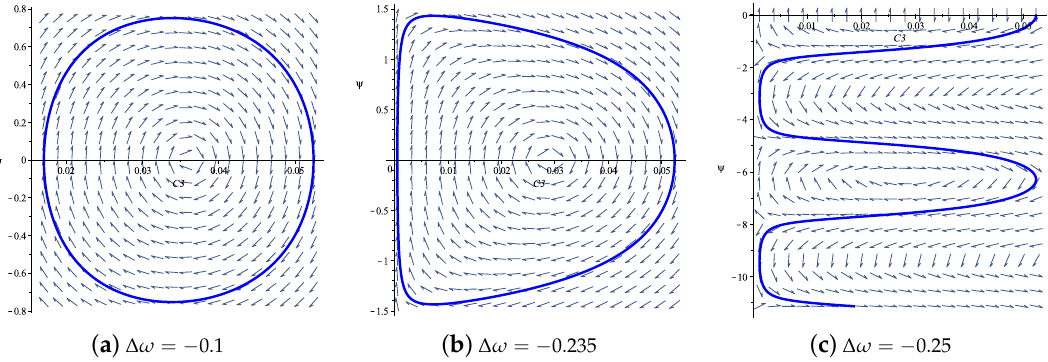
Figure 5. Phase portraits of the dynamical system of Equations (24)–(28) in ( C 3 , ψ ) variables for the triad from Table 1. Negative decreasing detuning.